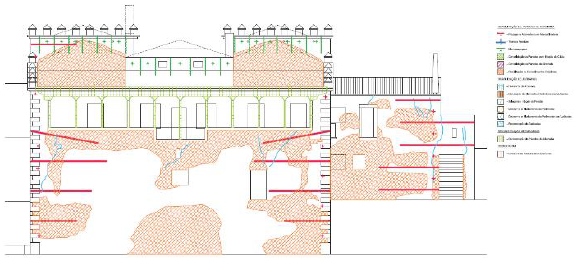
Figure 15. Structural interventions schematized over the elevation drawings.